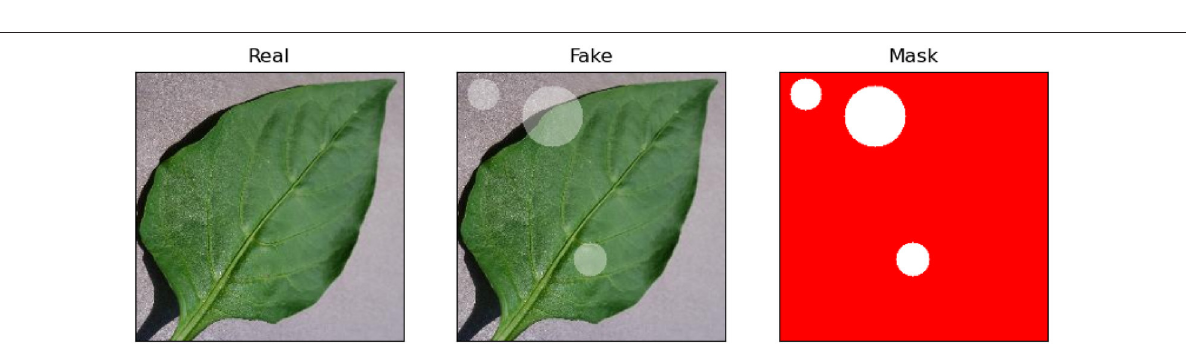
FIGURE 4 | Simulated leaves generation. The labeled pixels in the real mask are